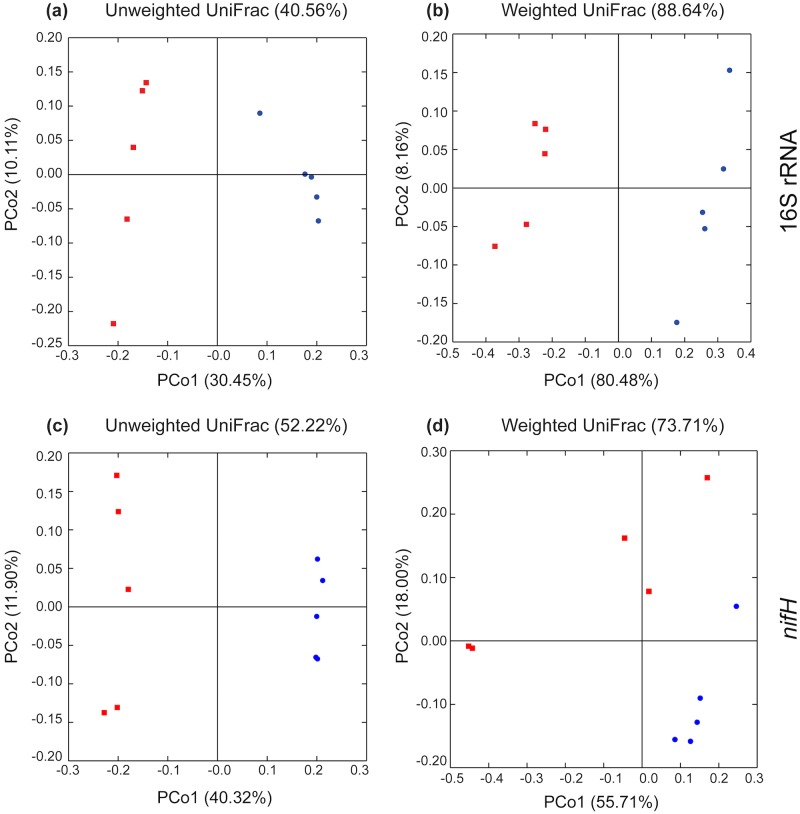
Principal coordinates analysis plots illustrating beta diversity of total bacterial communities based on 16S rRNA gene sequences (a and b) and nitrogen-fixing community based on nifH gene sequences (c and d) at Chionochloa pallens (CP) and Chionochloa teretifolia (CT) sample sites.UniFrac distance matrices are generated from OTUs of 97% identity. Unweighted plots (a and c) are based on the presence or absence of OTUs; weighted plots (b and d) are based on the relative abundance of OTUs. Red dots are samples from C. pallens sites and blue dots are from C. teretifolia sites.